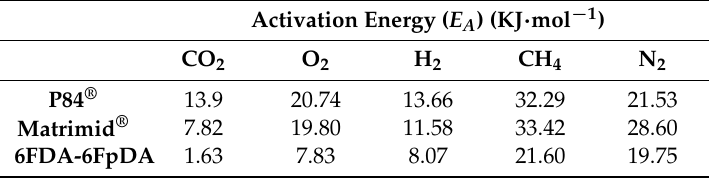
Table 3. Activation energies of permeance for the different gases for thin film composite membranes (TFCMs) prepared using 10 wt. % polymer solutions.